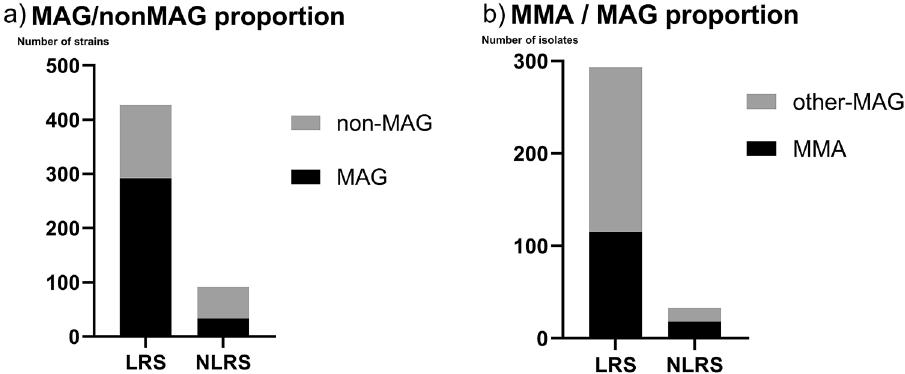
Figure 1. Proportion of Mycobacterium abscessus group (MAG) strains and subspecies separated for each sample type. ( a ) Non-MAG strains: rapidly growing mycobacteria species other than MAG; ( b ) non- M. abscessus subsp. massiliense (MMA) strains: subsp abscessus , subsp. bolletii and unclassified MAG